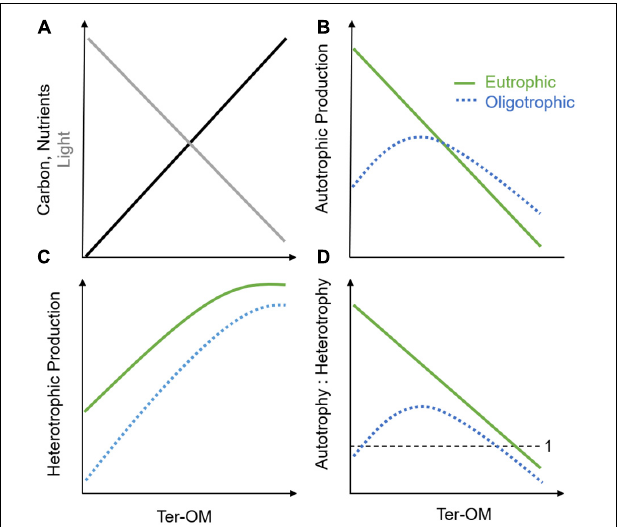
FIGURE 2 | Simplified conceptual framework illustrating the influence of increasing ter-OM on (A) baseline light (gray), nutrient, and carbon availability (black) in aquatic systems and hypothesized effects on (B) autotrophic production, (C) heterotrophic production, and (D) autotrophic vs. heterotrophic production in oligotrophic (blue, dotted line) and eutrophic (green, solid line) systems.